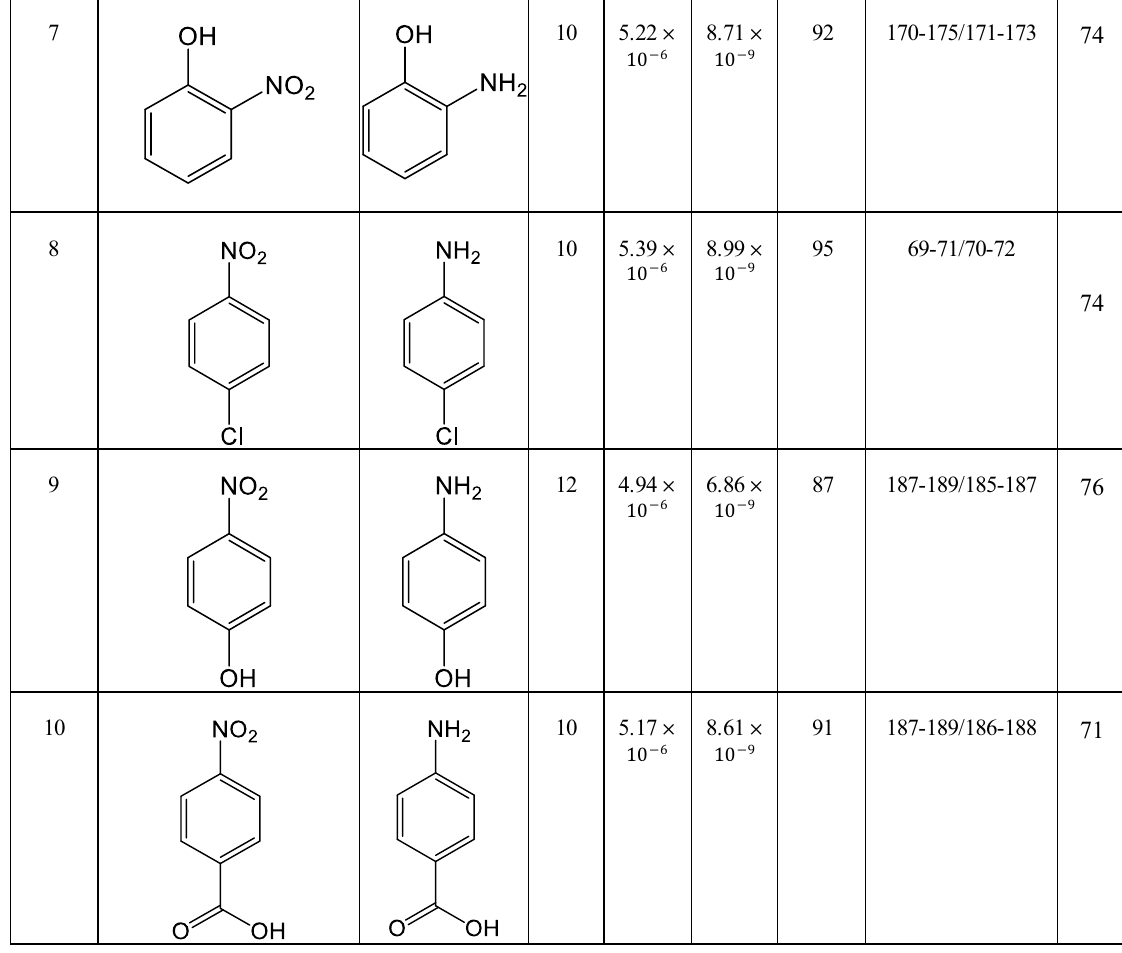
Table 2. The obtained yields after NB derivatives reduction to aniline by applying Fe 3 O 4 @Cur/Mel-Ag magnetic nanocomposite 0.02 g, NB 1.0 mmol, N 2 H 4 .H 2 O 5 mol%, and ethanol 2.0 mL, at 70 °C. *Liquid sample was identified with boiling point screening and thin-layer chromatography (TLC) (bp ca.184 °C) a The yields referred to the isolated